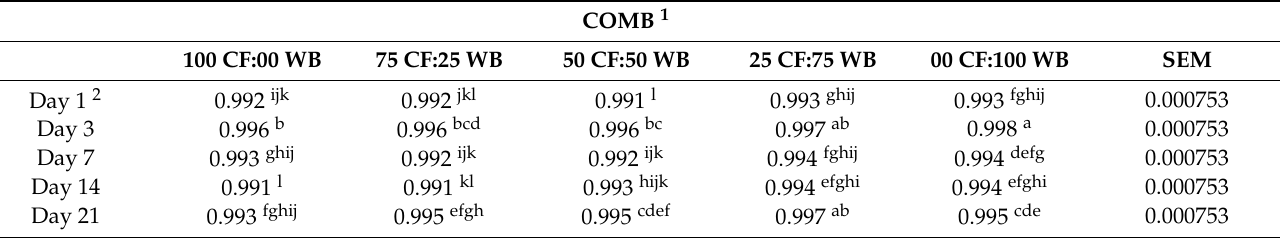
Table 8. Interactive effect of COMB × DAY on water activity (a w ) of pet food formulations during a simulated display.